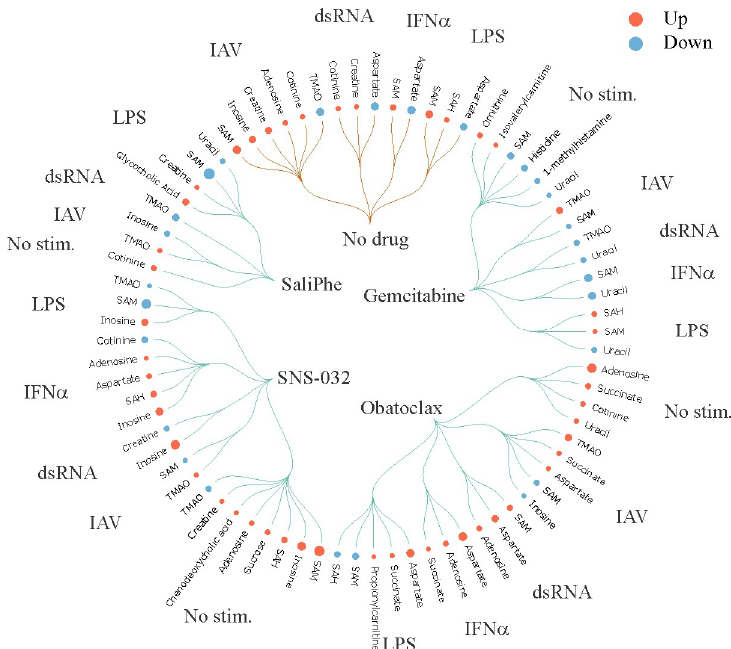
Figure 5. SaliPhe, SNS-032, obatoclax and gemcitabine, differentially affect levels of several polar metabolites in the culture media from stimulated PBMC-derived macrophages. PBMC-derived macrophages were treated with 3 μM SaliPhe, 0.1 μM SNS-032, 2 μM obatoclax, 1 μM gemcitabine or remained non-treated and infected with IAV (moi 1), or stimulated with 1 μg/mL dsRNA, 1 μg/mL LPS, 1 U/mL IFN-α, or remained non-stimulated. After 24 h, cell culture media were collected; polar metabolites were extracted and subjected to targeted metabolomics analysis. Metabolites, which levels were up- or down-regulated (log 2 FC (stimulus_no drug–mock_no drug) > 1.5 and <−1.5) in response to stimuli in the media of drug non-treated cells, are indicated with orange curves. Metabolites, which levels were up- or down-regulated (log 2 FC (stimulus_drug–stimulus_no drug) > 1.5 and <−1.5) in response to drug treatment in the media of activated cells, are shown in green. The size of the red and blue circles corresponds to fold changes in the level of metabolites.